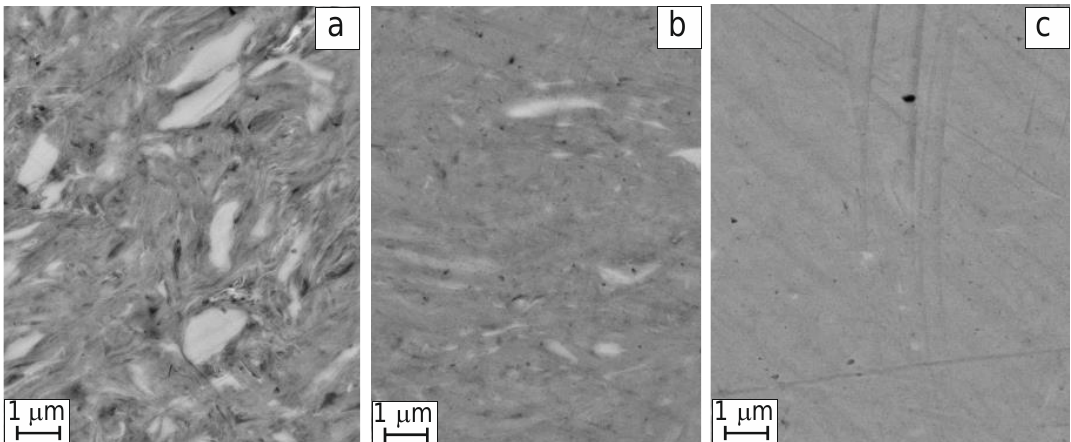
Figure 2. Cross sections of alloyed powder particles after HEBM processing for 30 ( a ), 60 ( b ), and 90 min ( c ) (SEM images in backscattered electrons).